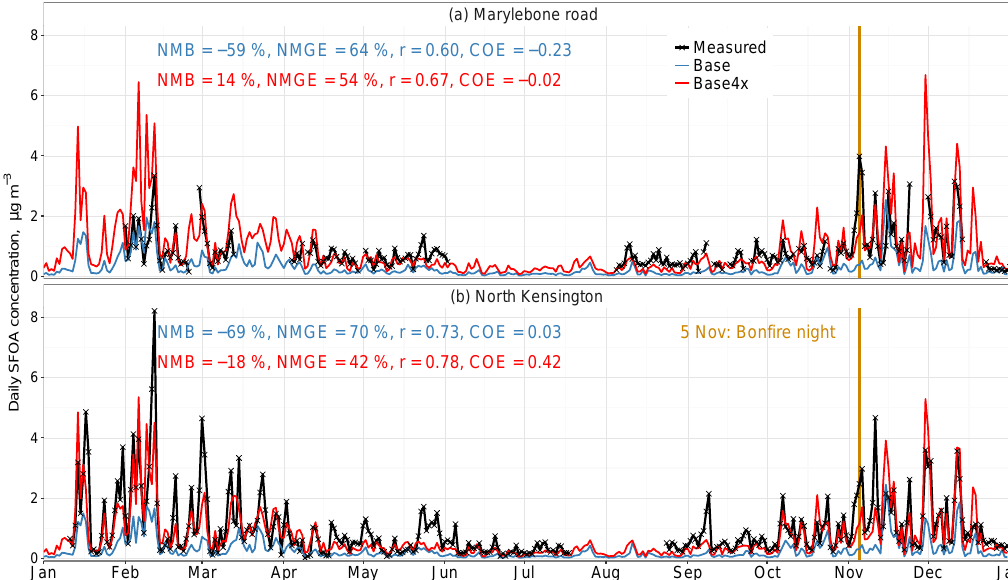
Figure 5. Time series of measured and modelled ( Base and Base4x experiments) daily average SFOA concentrations at the (a) Marylebone Road, and (b) North Kensington measurement sites, year 2012. The vertical line marks the date of “bonfire night”, 5 November. The annual average measured SFOA concentrations at these sites were 0.9µgm − 3 at Marylebone Road, and 1.0µgm − 3 at North Kensington.